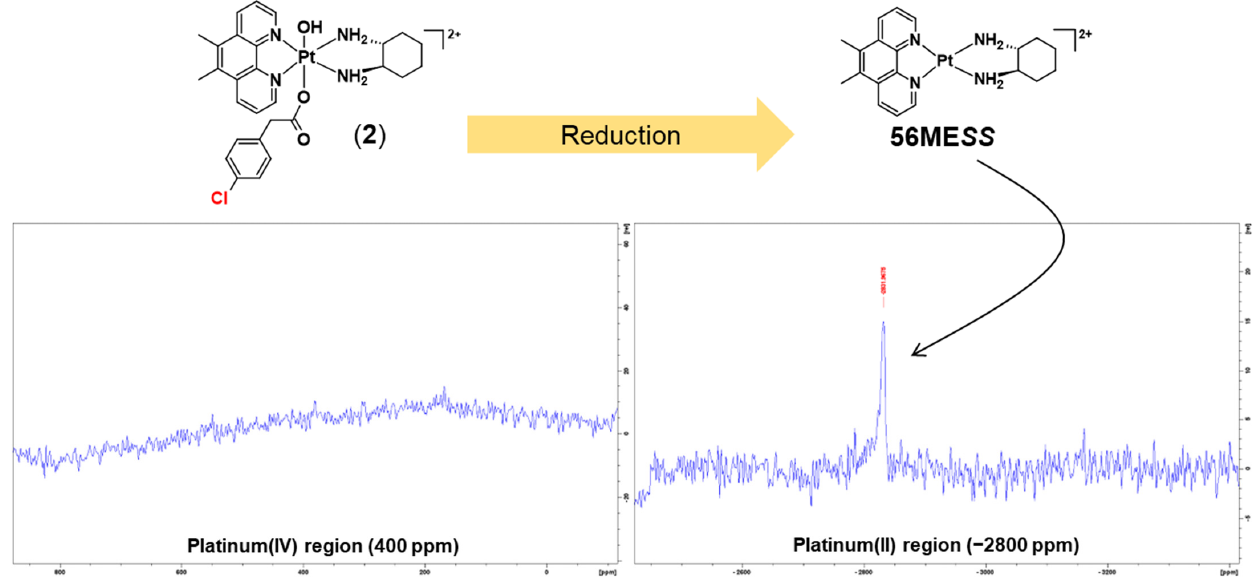
Figure 18. 1D − 195 Pt − NMR spectra of 2 with PBS and AsA in D 2 O, within the regions of − 2800 and 400 ppm at 37 °C, highlighting its complete reduction after 1 h from the final 1 H − NMR experiment.